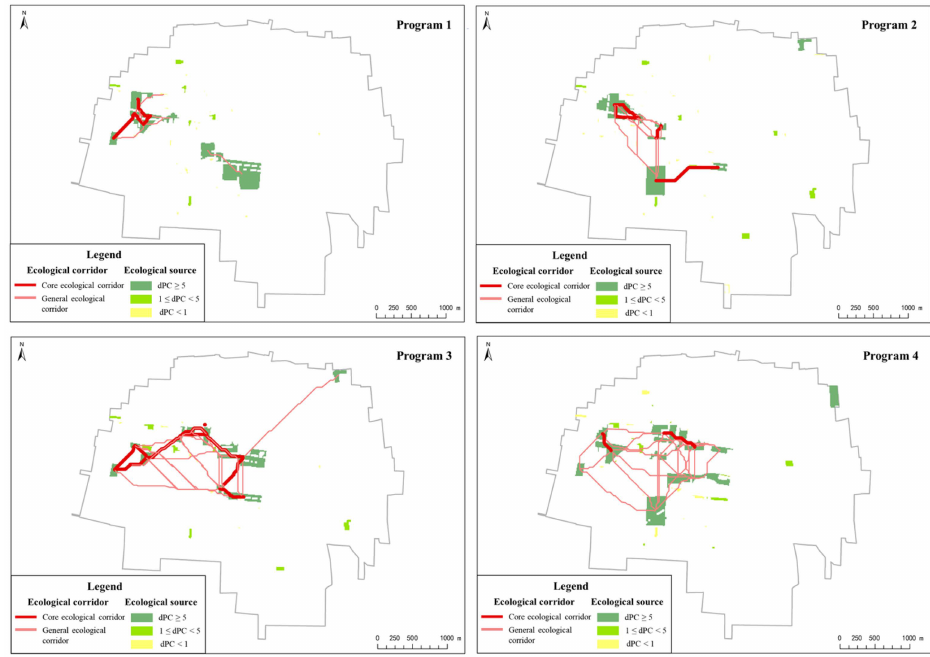
Figure 8. Identification of ecological corridors in the alternative planning programs of Zepan